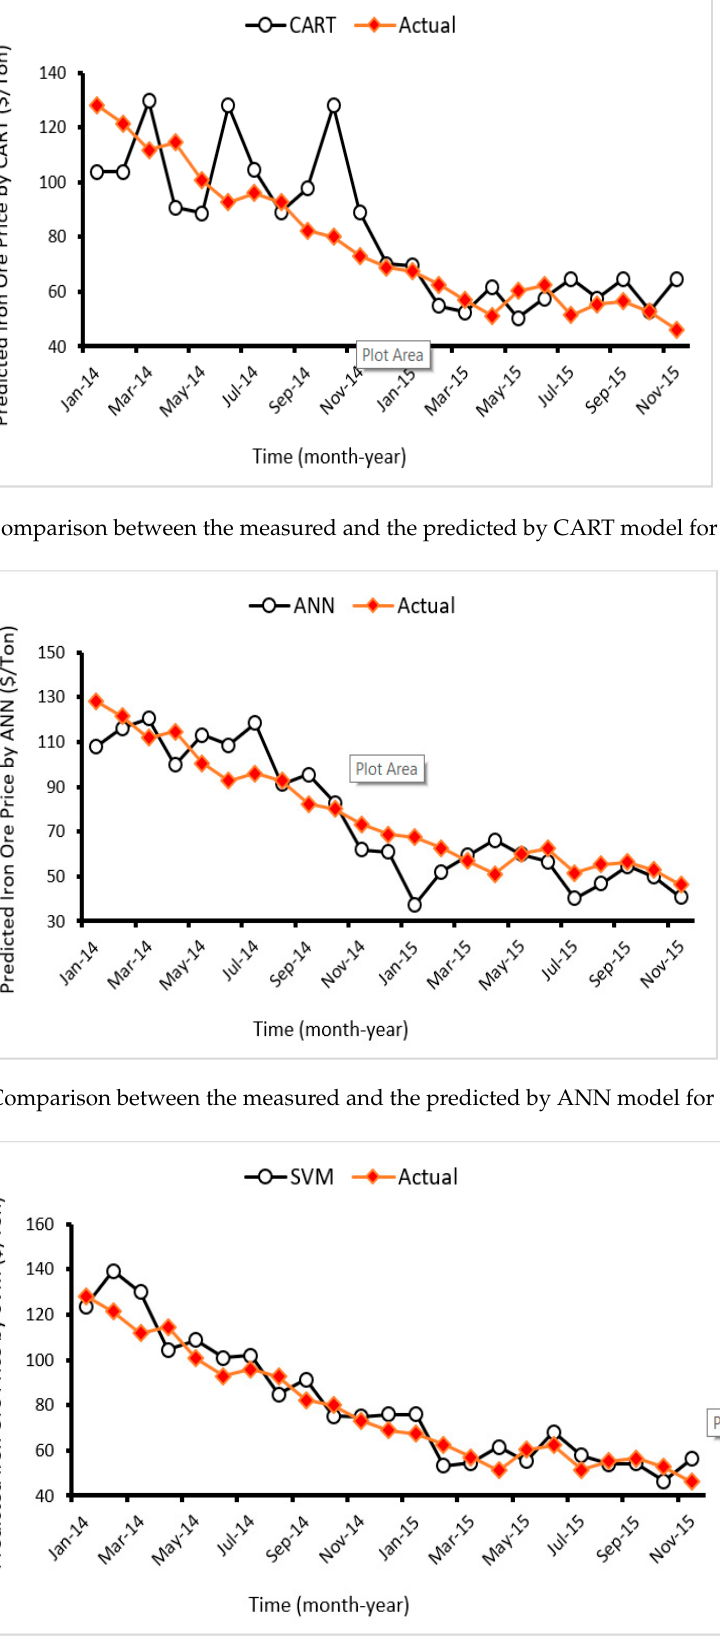
Figure 14. Comparison between the measured and the predicted by group method of data handling (GMDH) model for test stage. Aside from that, the obtained results of performance prediction for all proposed techniques are tabulated in Table 6. As it can be seen in this table, higher performance prediction is related to results of GMDH model in both train and test phases. Although the other methods e.g., SVR and ANN are also suitable for prediction purposes and they can provide an acceptable level of accuracy, the highest prediction capacity was achieved developing GMDH predictive approach. Hence, this technique can be introduced as a new predictive model in estimating iron ore price. Table 6. The obtained results of performance prediction for testing datasets. Model